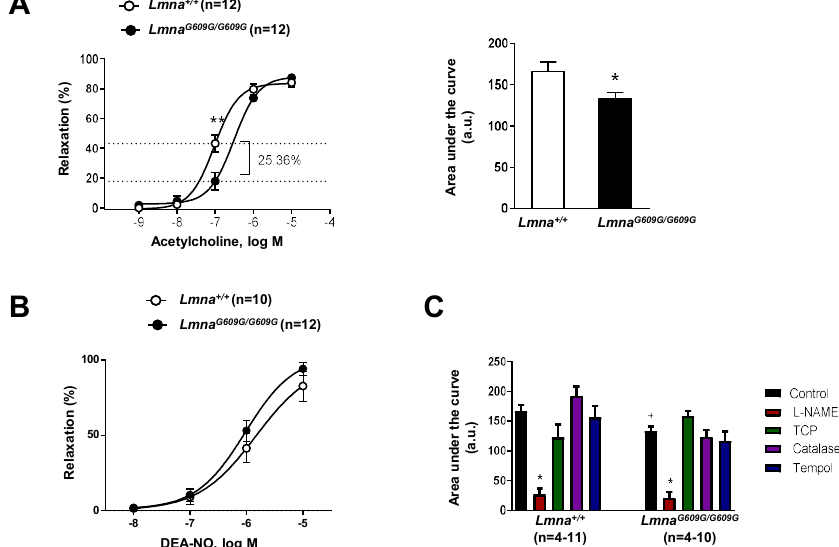
Figure 2. Defective endothelium-dependent aortic dilation in Lmna G609G / G609G mice. Thoracic aortas from 14-week-old progeroid Lmna G609G / G609G mice (ubiquitous progerin expression) and wild-type mice ( Lmna +/+ ) were analyzed by wire myography ( n = 12 for each genotype). ( A ) Endothelium-dependent vasodilation induced by acetylcholine (left) and representation of the area under the curve (AUC; a.u.: arbitrary units) (right). ( B ) Endothelium-independent vasodilation induced by the NO donor diethylamine NONOate (DEA-NO). ( C ) Representation of area under the curve from acetylcholine-dependent relaxation curves performed in the absence (control) or presence of L-NAME, tranylcypromine (TCP), catalase, or Tempol. Statistical differences were analyzed by two-way ANOVA with Bonferroni’s post-hoc test for acetylcholine and DEA-NO data, and by one-way ANOVA for AUC data. * p < 0.05 and ** p < 0.01 compared with corresponding control in ( A ) and ( C ); +, p < 0.05 Lmna +/+ versus Lmna G609G/G609G in ( C ).